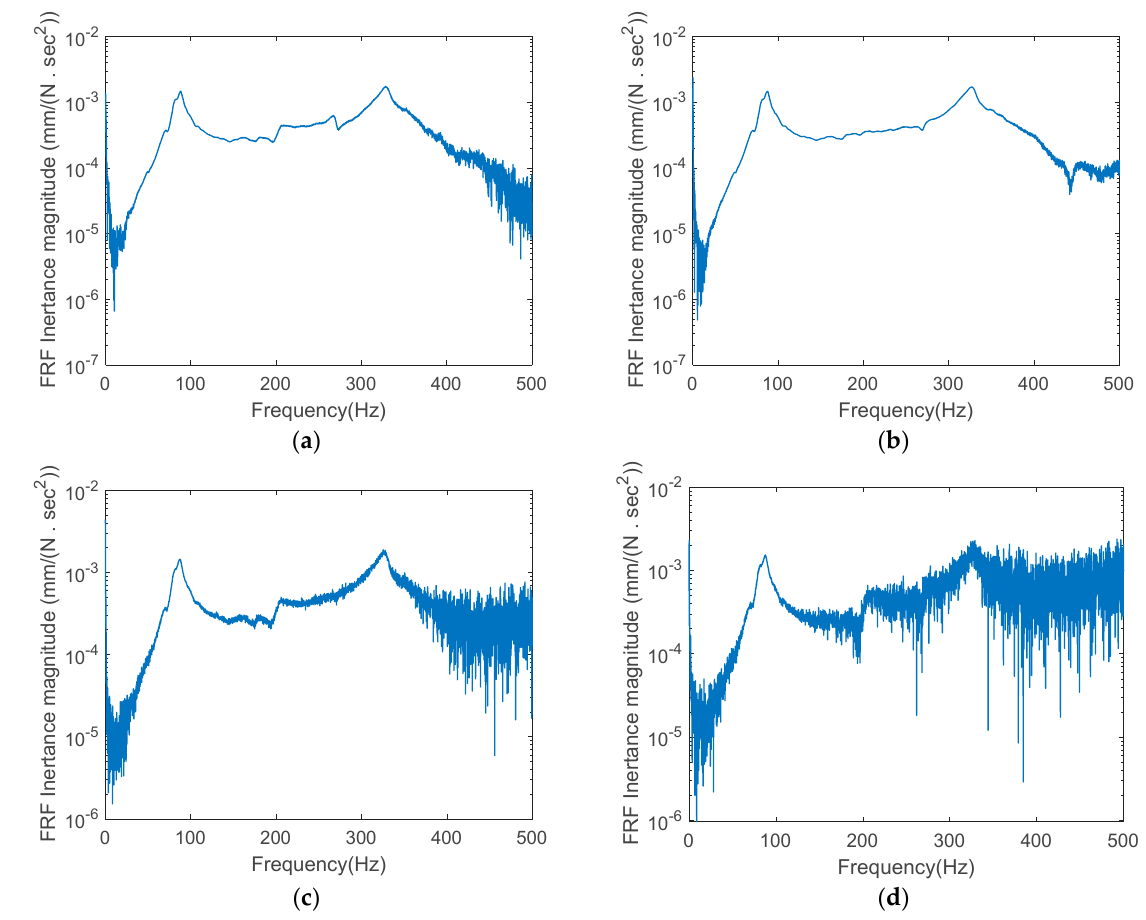
Figure 7. Impact hammer test.